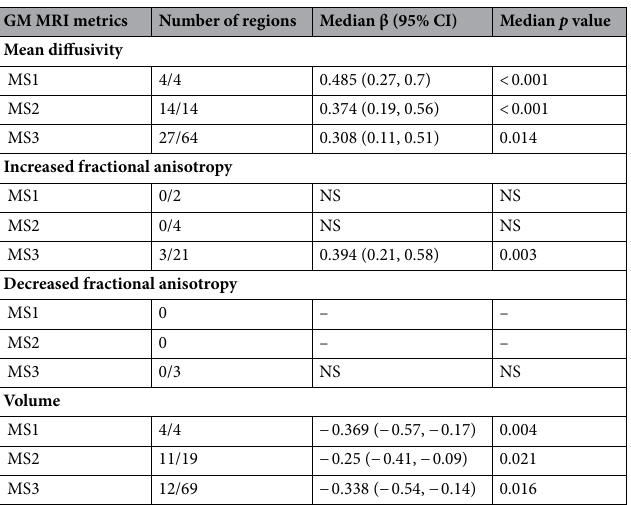
Table 2. Association between DTI and GM atrophy measures and white matter lesion volume in each group of MS patients. Analyses were performed with the GM regions showing abnormal diffusion or volume in each group of patients. CI, confidence interval; MS, multiple sclerosis; NS, not